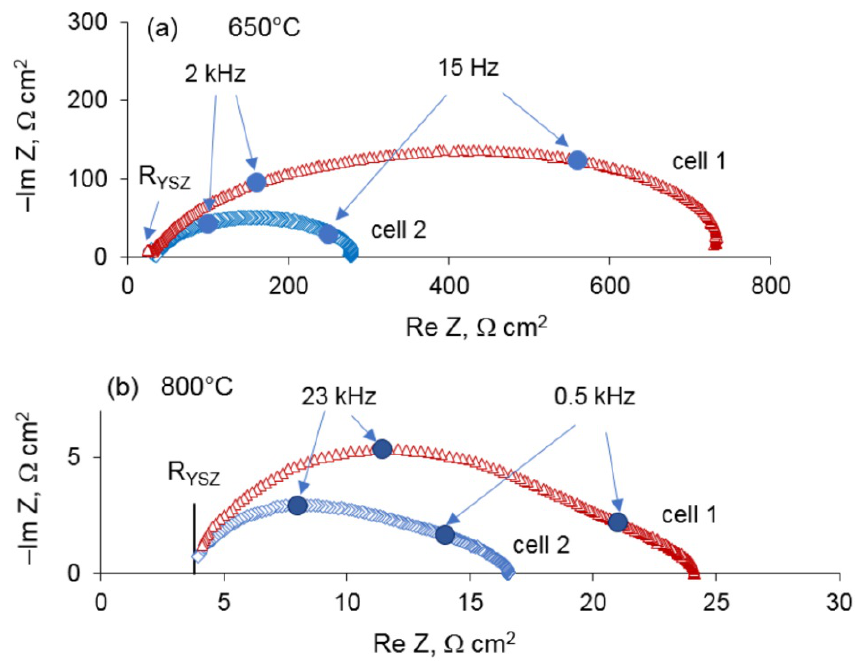
Figure 7. Impedance spectra of cells 1 and 2 at ( a ) 650 and ( b ) 800 °C.